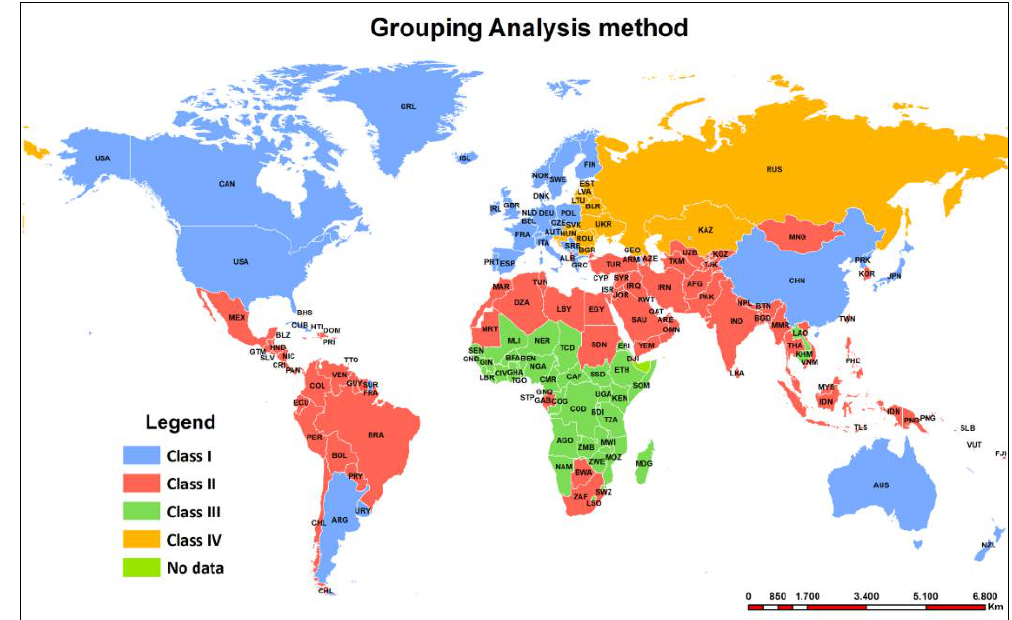
Figure 4. Global distribution of mortality causes by the grouping analysis methods. Source of data: The Institute for Health Metrics and Evaluation, World Bank.